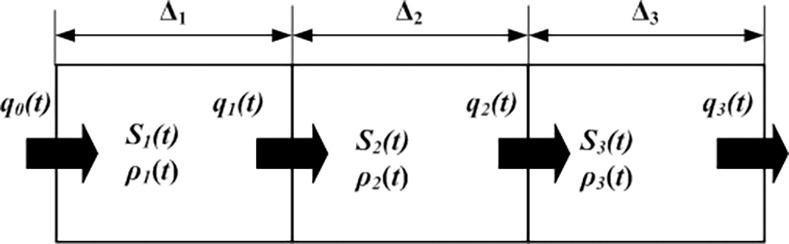
Motorway section.